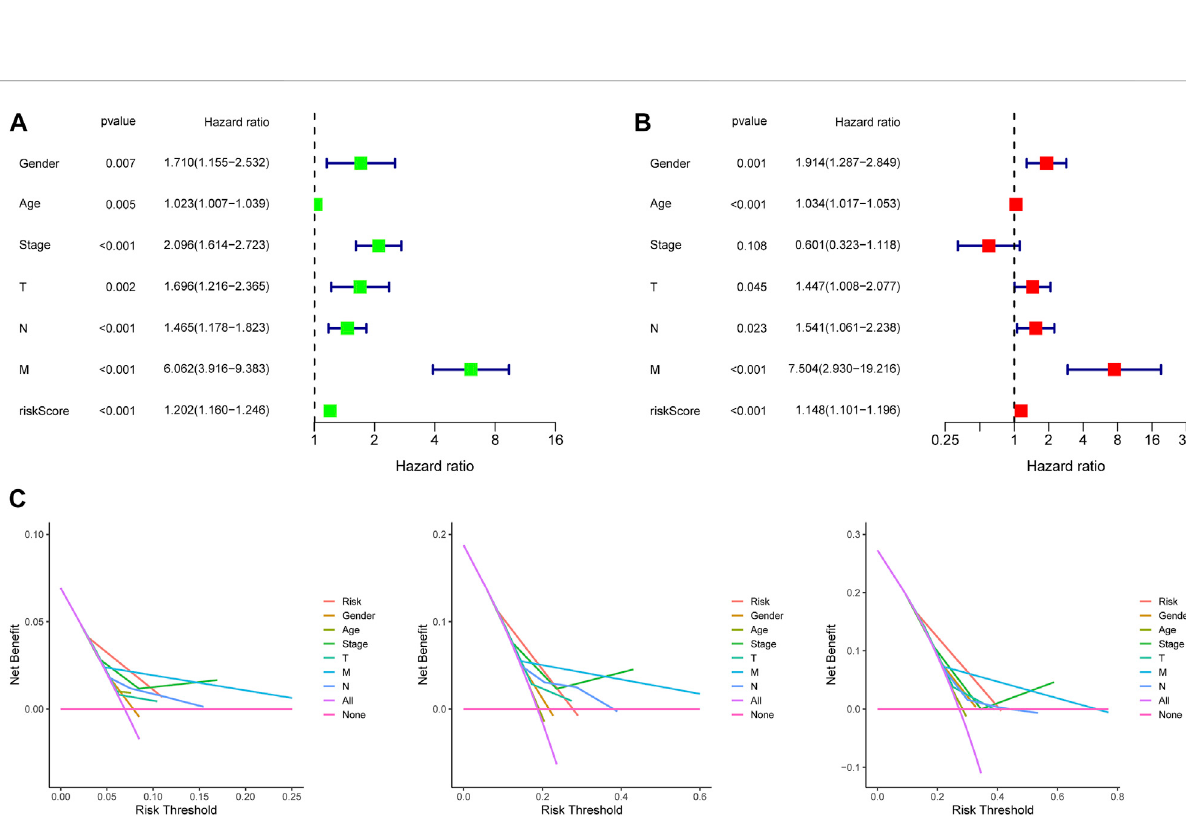
FIGURE 5 Independence detection and decision curve analysis of the constructed risk prediction model. (A,B) Independent prognostic-related factors screenedoutbyCOXregressionanalysis. (C) .The y -axismeasuresthenetbene fi t.Theredlinerepresentstheconstructedriskpredictionmodel.The purple line represents the assumption that all the patients were predicted using none indicators. The blue line represents the assumption that the patientswerepredictedusingall indicators. Thedecision curveshowed thatusingthisconstructed riskprediction modelinthecurrent studyto predict COAD patients ’ survival risk adds more bene fi t than the indicator-all-patients scheme or the indicator-none